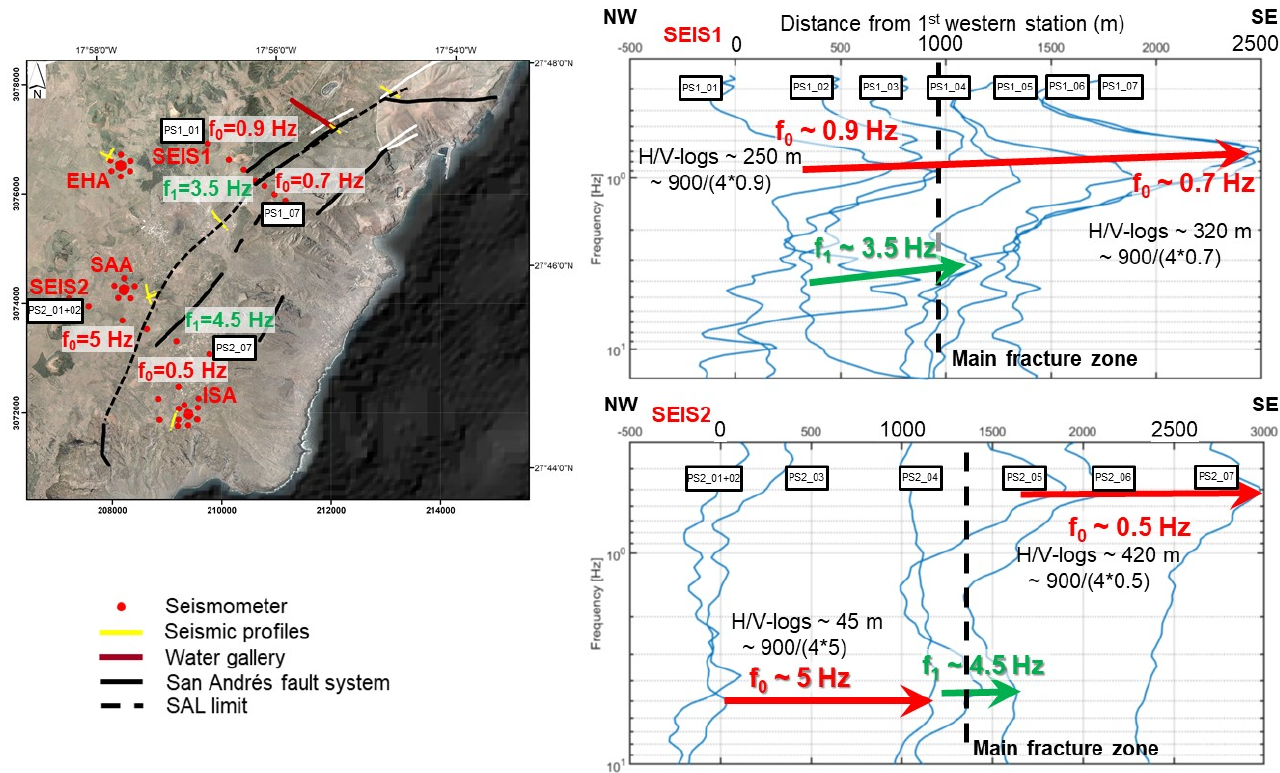
Figure 6. Analysis (H/V rations) of the ambient noise recordings along the two seismological profiles (SEIS1, SEIS2) with interpretation in terms of fundamental (f 0 ) and higher, second (f 1 ) resonance peak